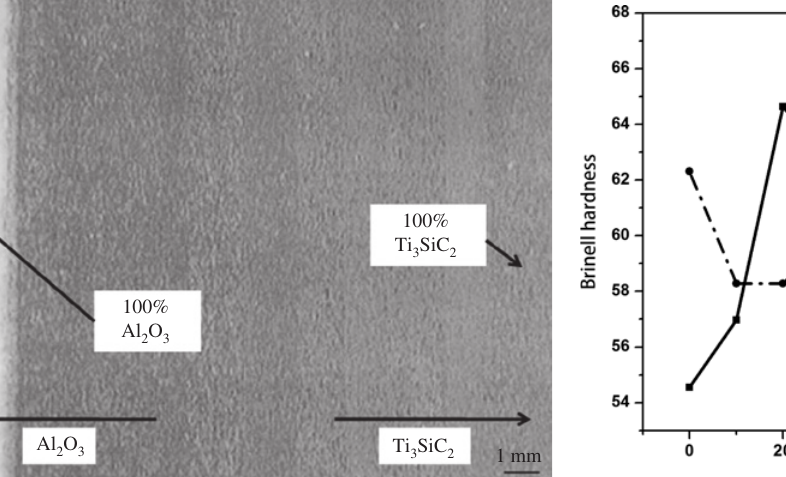
O /Ti SiC FGM [53]. Figure 11: Brinell hardness of each part of TiN/HAP FGM 2 3 3 2